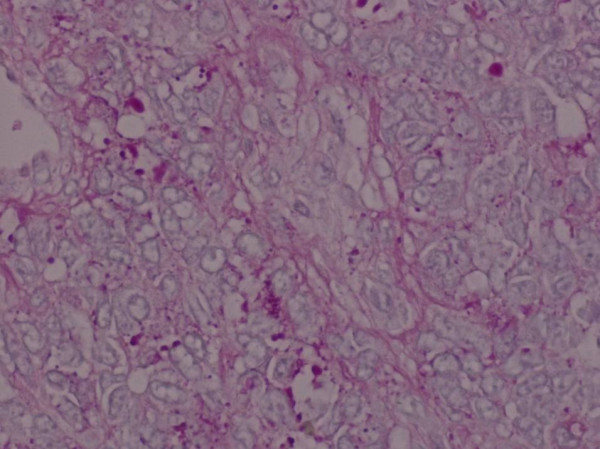
Glycogen in cells.